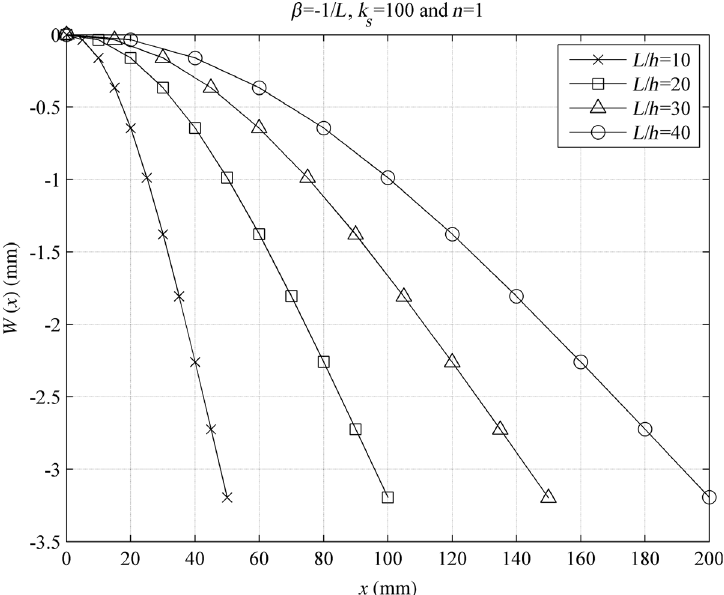
mass density in the governing differential equation of motion for a beam made of conventional